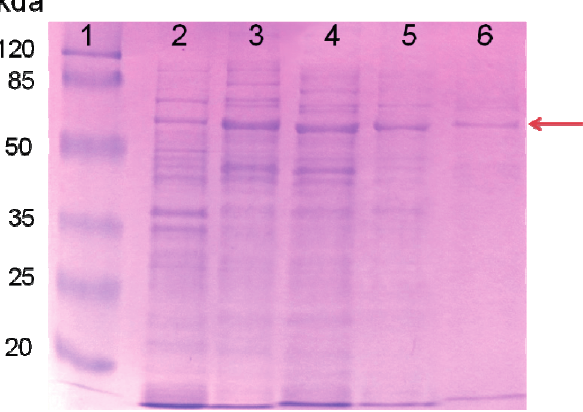
Figure 1. SDS-PAGE of the purified recombinant isocitrate lyase (ICL) protein. The arrow indicates the ICL protein. Lane 1, molecular mass markers (in kDa); lane 2, whole cell extract of E.coli RIL (DE3) with control vector pQE2 before induction; lane 3, supernatant of induced E.coli RIL (DE3) containing recombinant pQE2 plasmid (pHis- aceA ) after 0.1 mM IPTG; lane 4, flow through sample after Ni-NTA column; lane 5, washed sample; and lane 6, purified ICL protein. The size of molecular mass markers is indicated on the